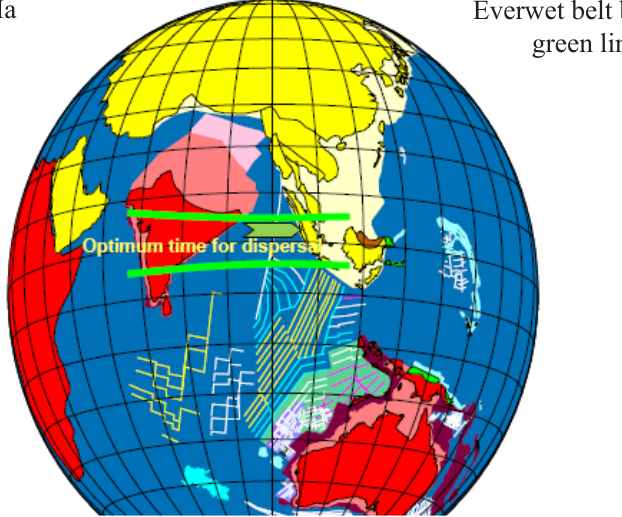
Figure 2 : Location of Indian Plate in the equatorial belt at around 45 Ma providing the first and the last corridor of equatorial perhumid climate in this region and the only opportunity for migration of taxa confined to equatorial perhumid climate from India Plate to SE Asia (Adapted from Hall, 2009 and van Hinsbergen et al .